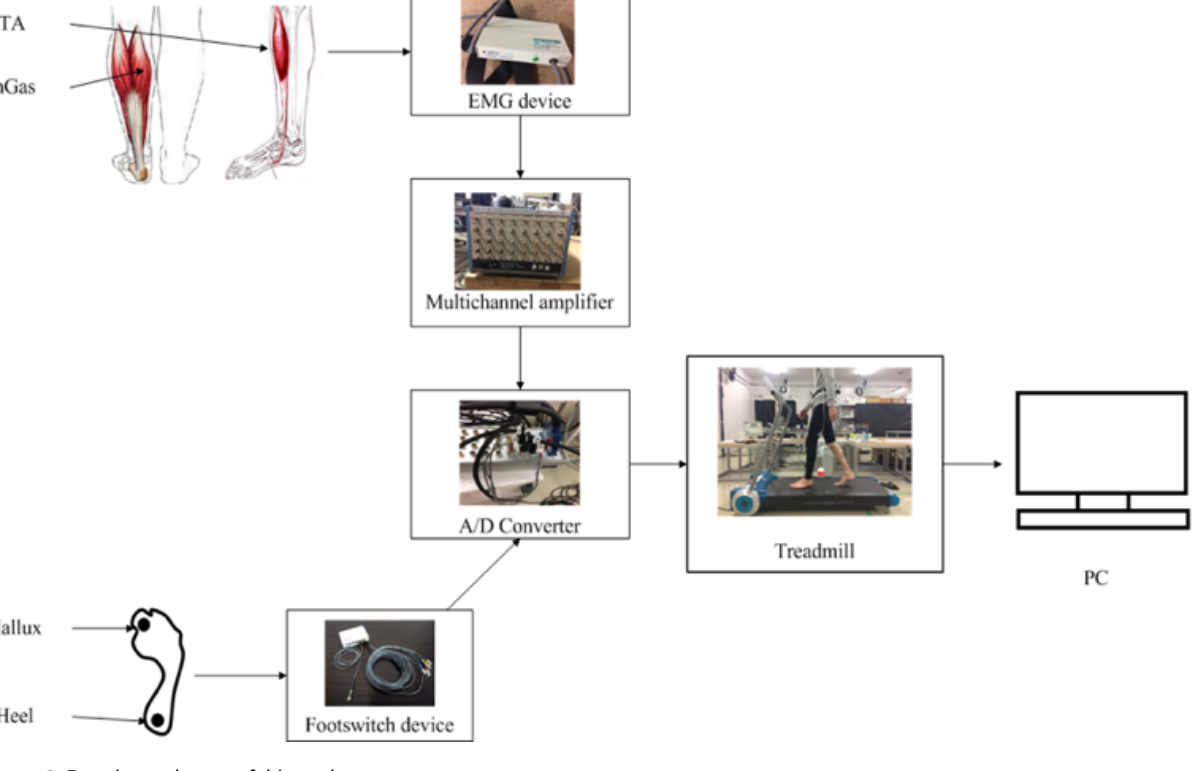
Figure 3: Experimental setup of this study